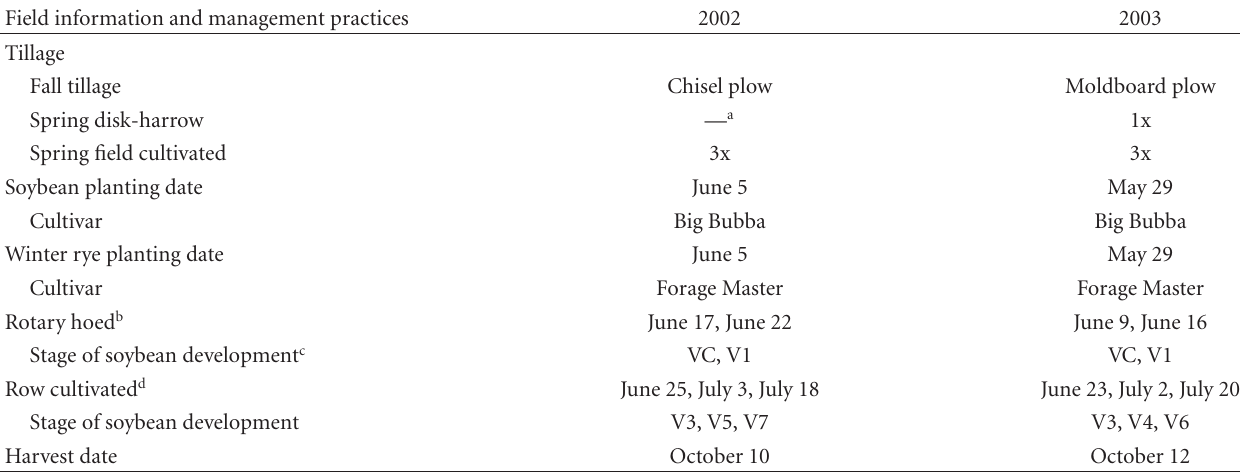
Table 1: Field information and selected management practices in 2002 and